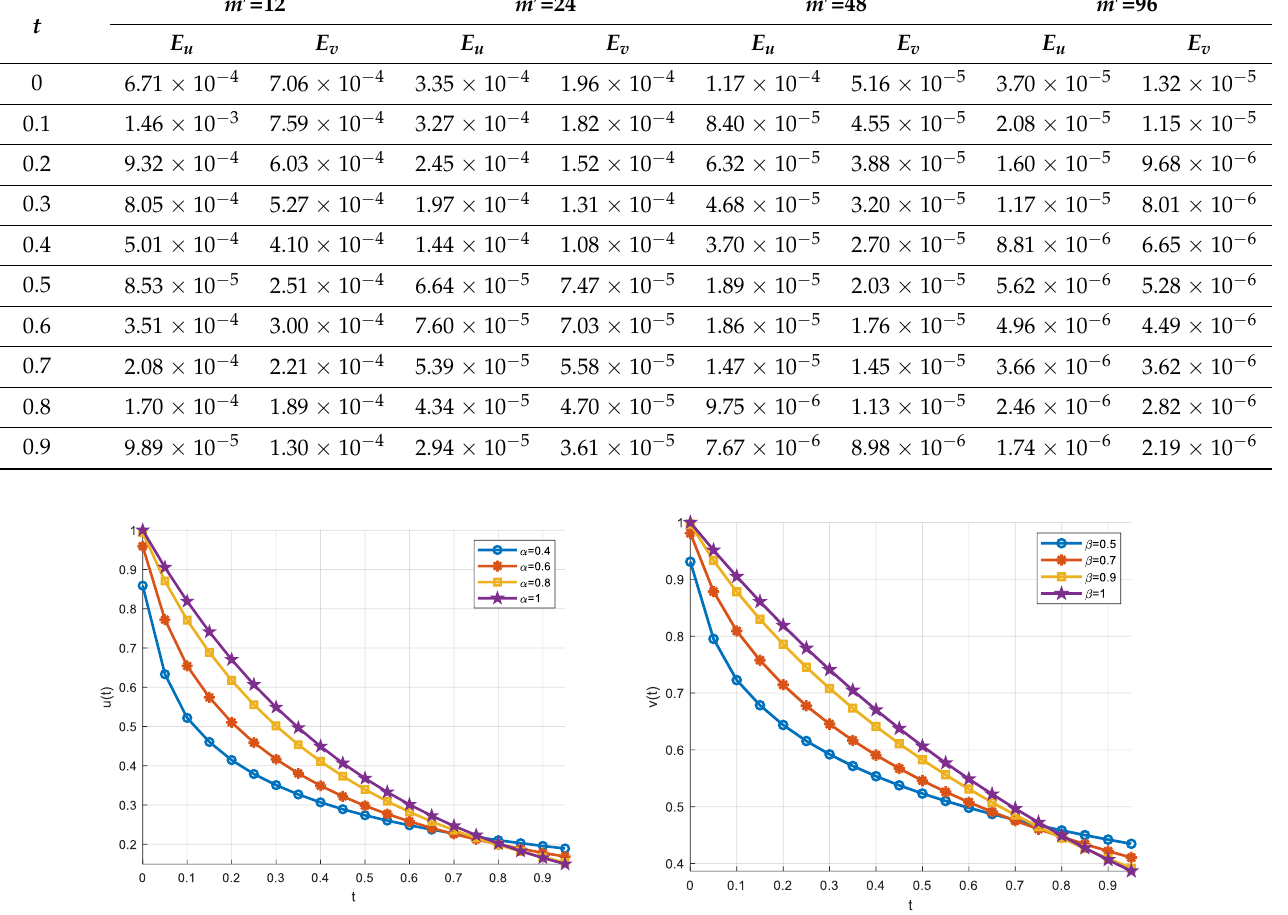
Figure 4. Numerical solutions